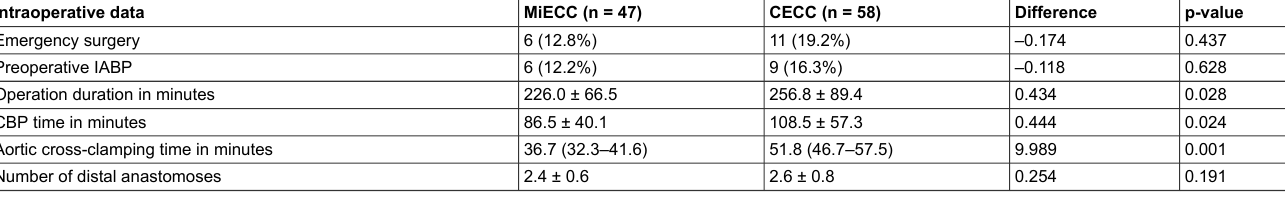
Table 2: Intraoperative data after propensity score matching and after inverse probability of treatment weighting